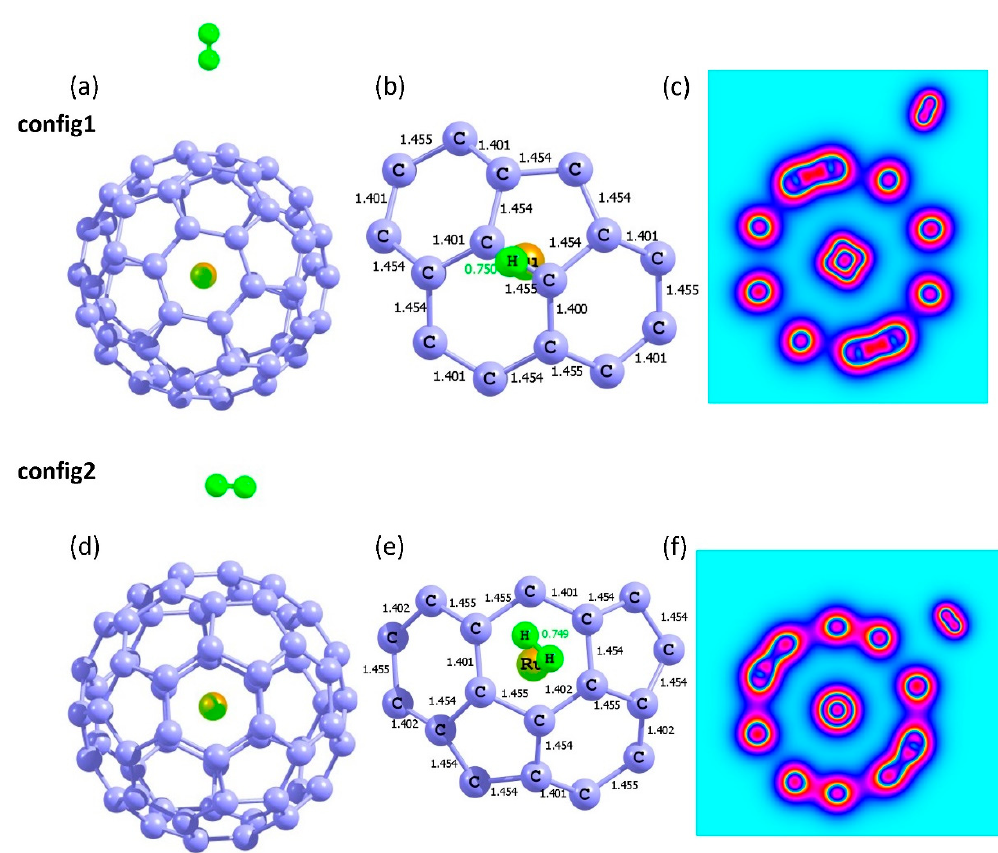
Figure 8. ( a ) Relaxed configuration (configuration 1) of molecular hydrogen adsorbed on the surface of Ru@C 60 , ( b ) bond distances (H–H and C–C) in the relaxed configuration and ( c ) charge density plot showing the non-covalent interaction. Similar figures ( d – f ) are shown for configuration 2. Table 6. Calculated adsorption energies with respect to gas phase molecular hydrogen, H–H bond distances and Bader charges on the Ru and H atoms.